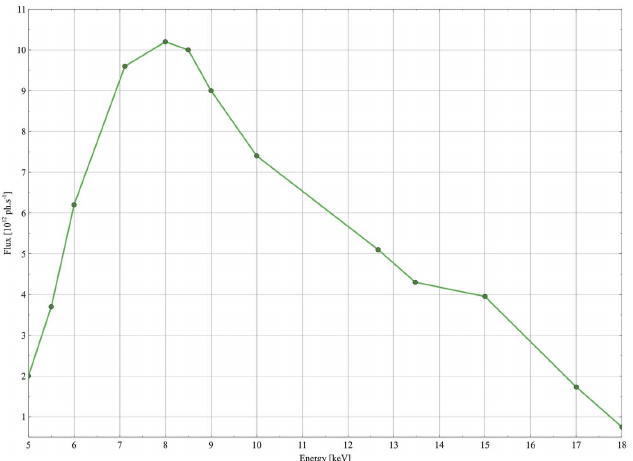
Figure 3 AMX photon flux at the sample position across the photon energy range 5–18 keV. Measurements performed at 400 mA ring current. At lower energies, the flux is diminished due to absorption in the Be exit window and the remaining air path to the sample ( (cid:6) 30 cm). A 50 m m-thick electronic-grade CVD diamond single-crystal BPM further attenuates the beam intensity but can be